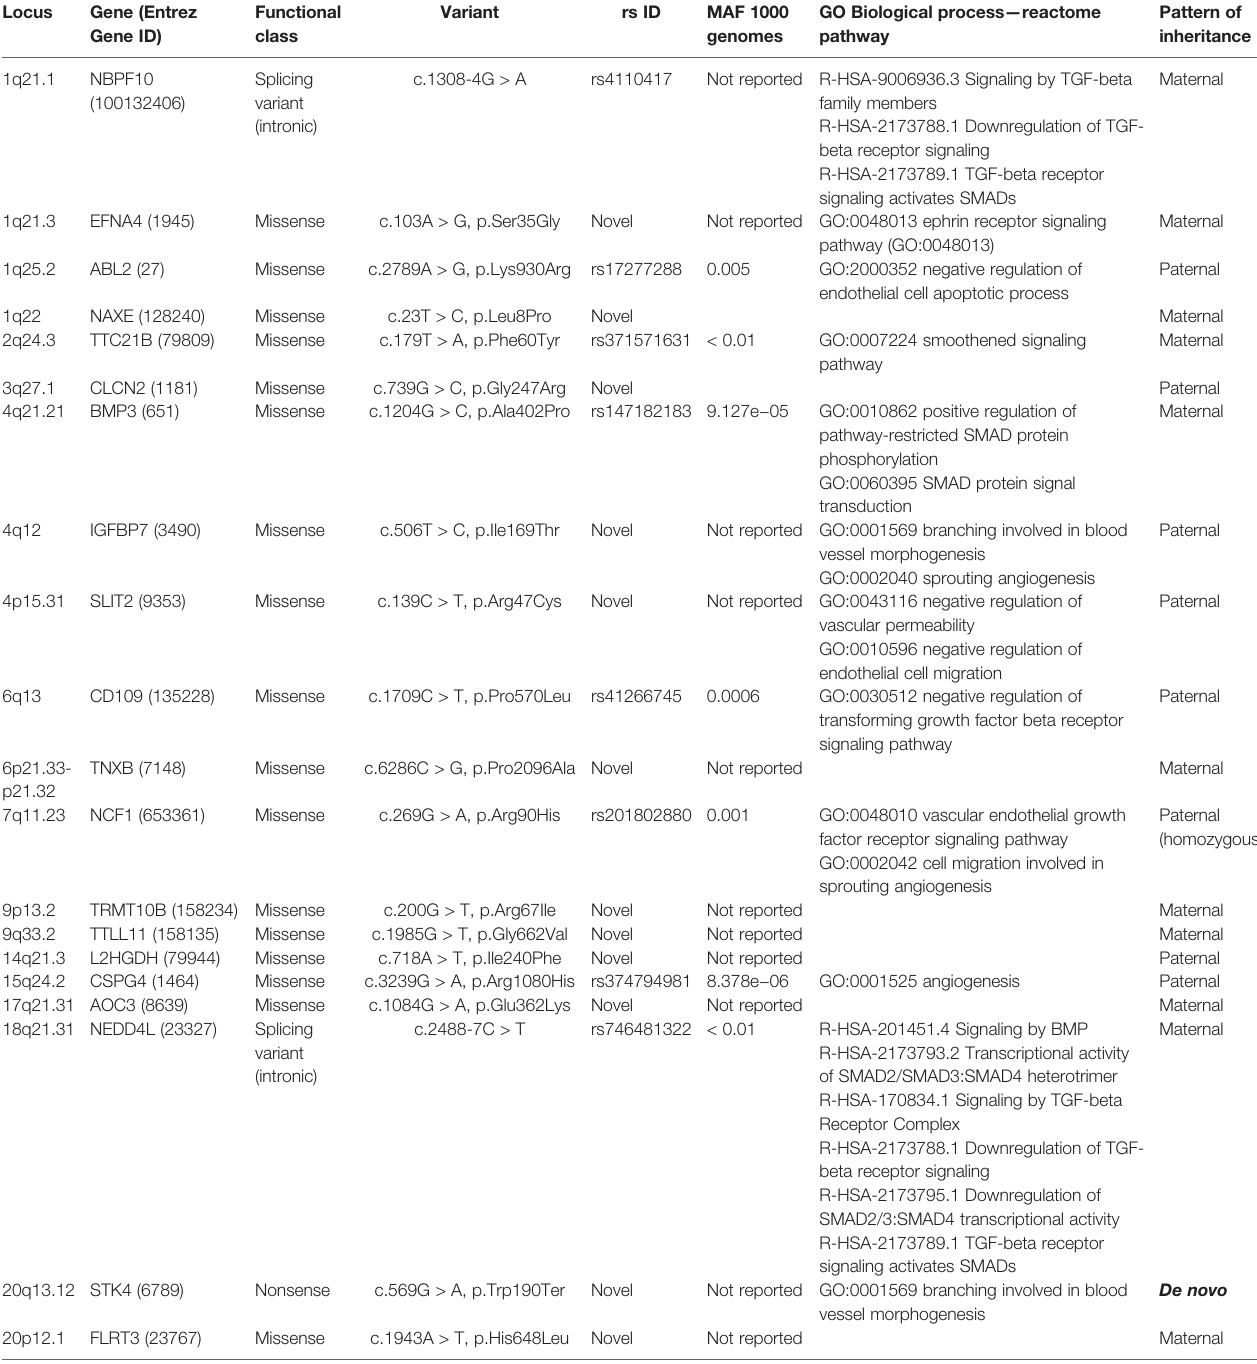
TABLE 1 | Likely gene-disrupting (LGD) variants selected as potentially involved in arteriovenous malformation (AVM)